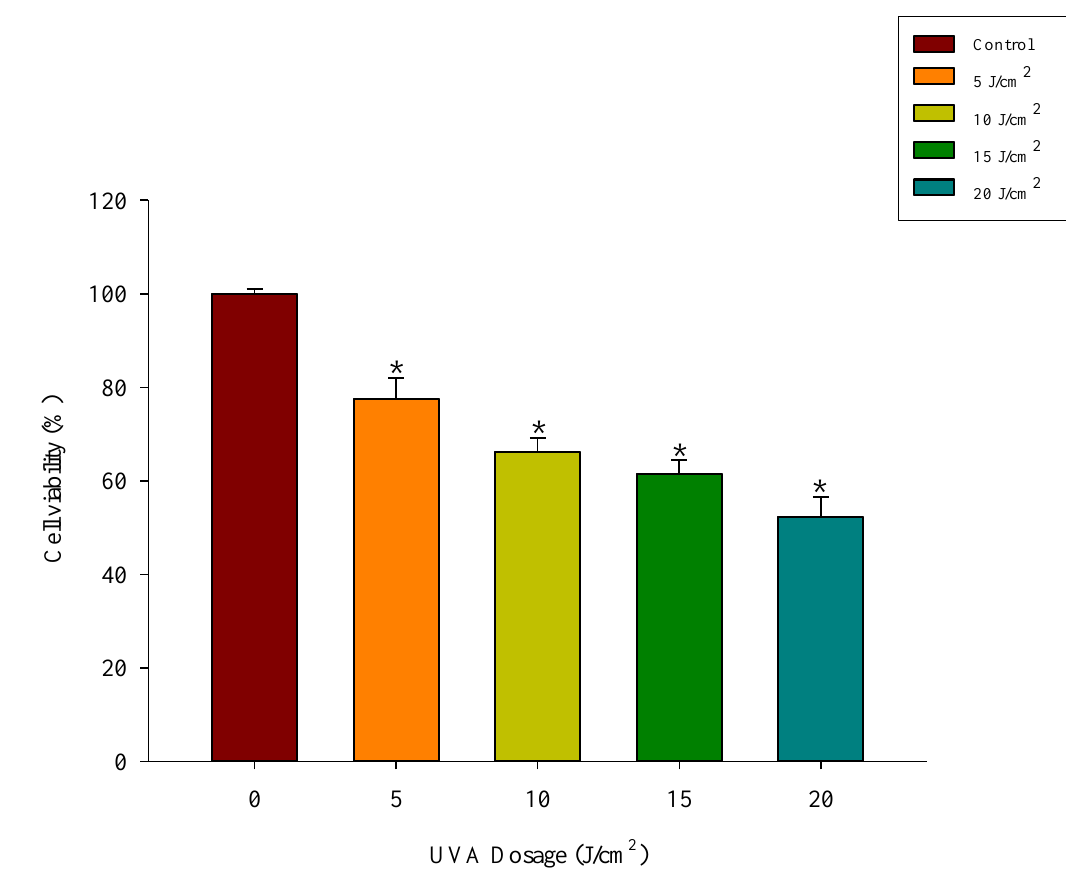
Figure 3. Effect of UVA irradiation on cell viability. Cells were irradiated with the indicated single doses of UVA radiation (5 – 20 J/cm 2 ). Viability was determined via MTT assay at 24 h. Experiments were conducted in triplicate ( n = 3). Data are expressed as the mean ± SD. * Significant differences compared to the control group ( p < 0.05).